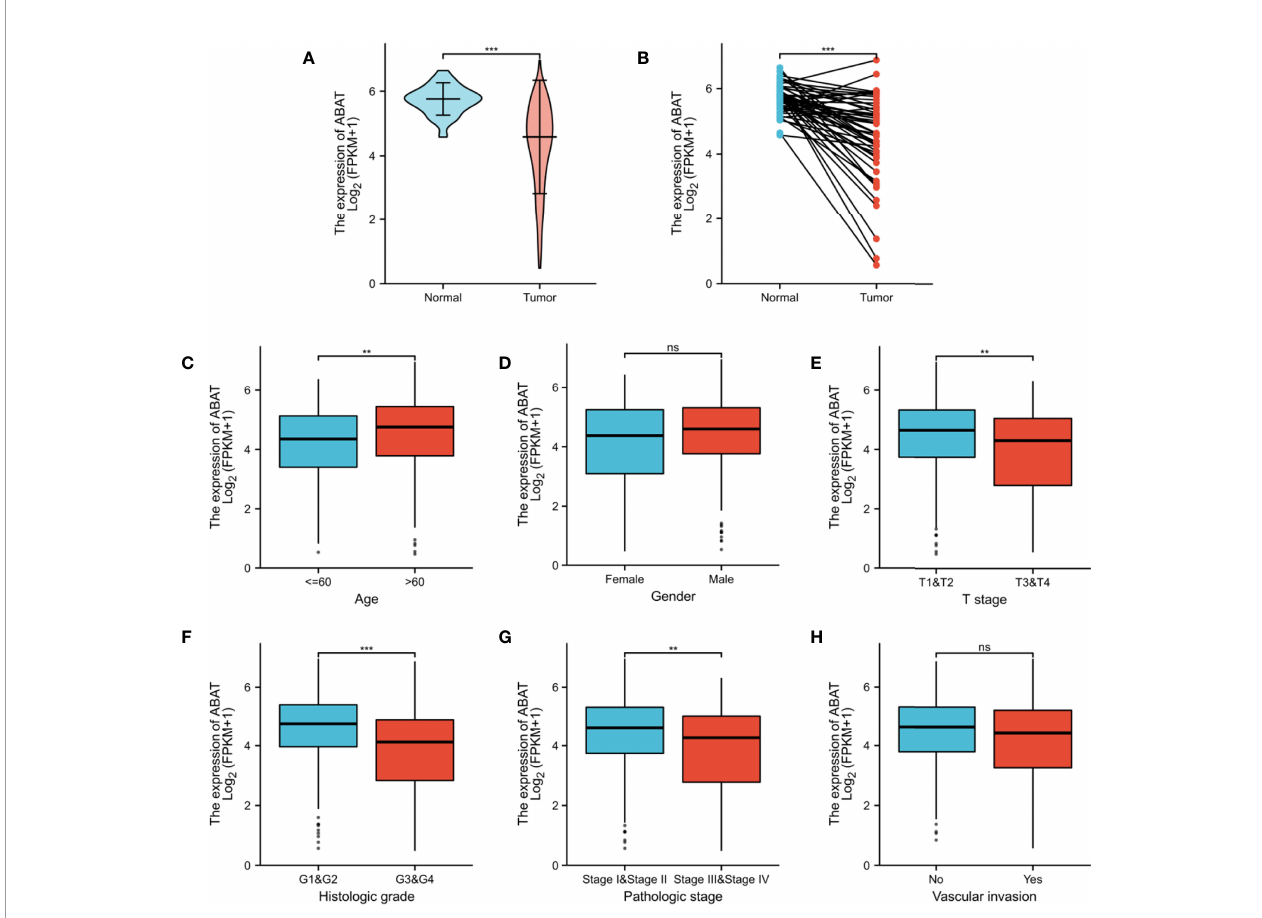
FIGURE 1 | ABAT mRNA expression and its association with clinical characteristics in HCC. (A) Expression level of ABAT mRNA in HCC tissues and normal tissues (P < 0.001). (B) Expression level of ABAT mRNA in HCC tissues and adjacent tissues (P < 0.001). Association of ABAT mRNA expression with (C) Age, (D) Gender, (E) T stage, (F) Histologic grade, (G) Pathologic stage, (H) Vascular invasion. NS: P = 0.05 or higher; **P < 0.01; ***P <